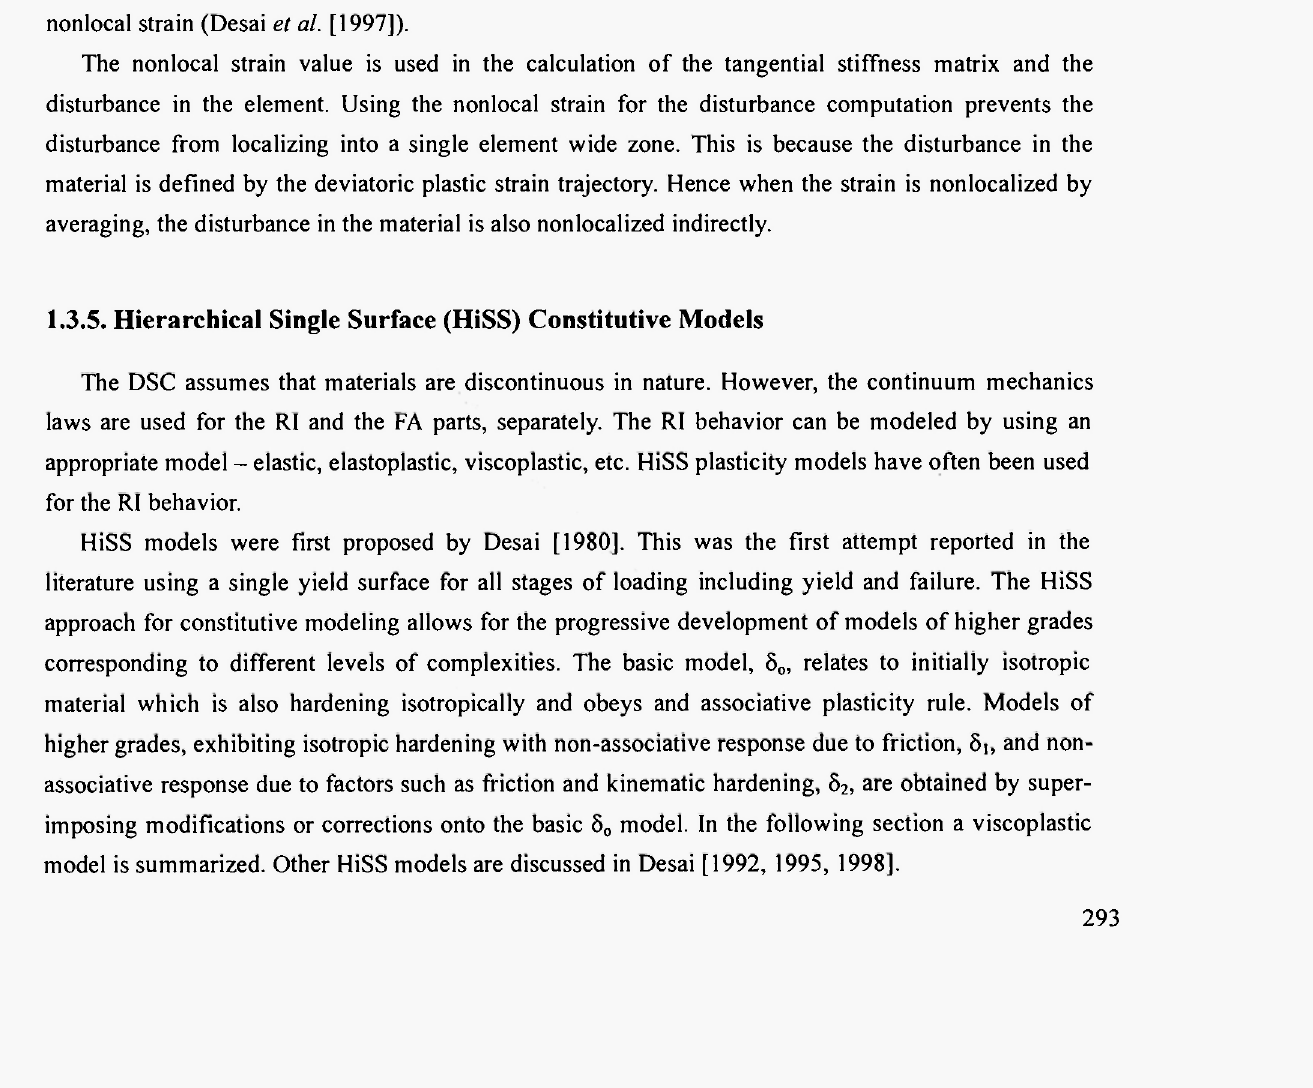
Fig. 1.5: Nonlocal continuum averaging